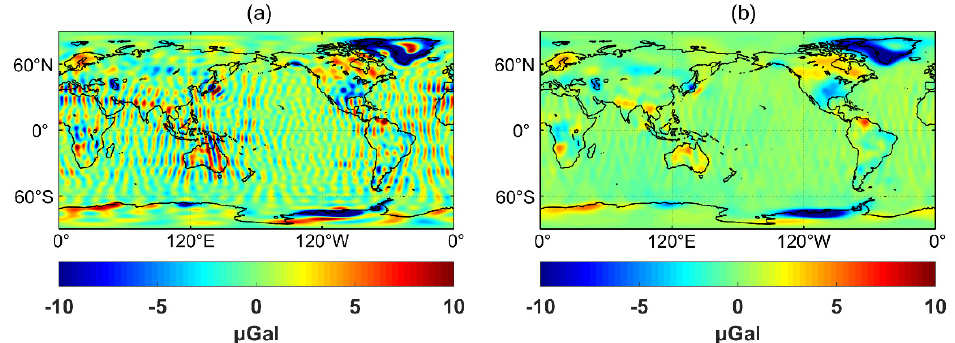
Figure 7. GRACE global gravity changes between the mean of 2011+2012 and 2009+2010. ( a ) Without any filter; ( b ) With 300 km Gaussian smoothing.